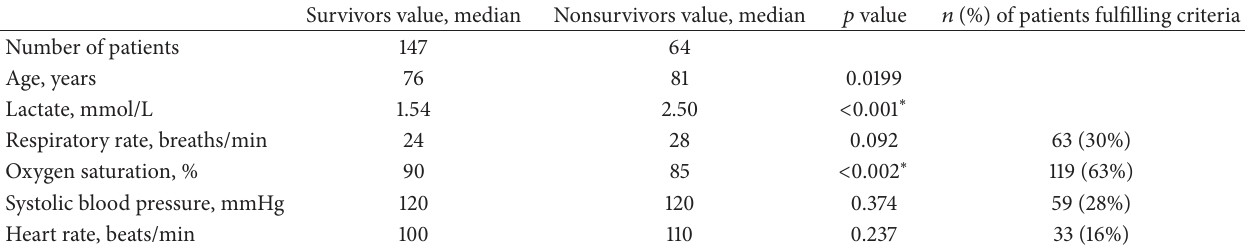
Table 2: Characteristics of survivors and nonsurvivors after 30 days, univariate analysis.